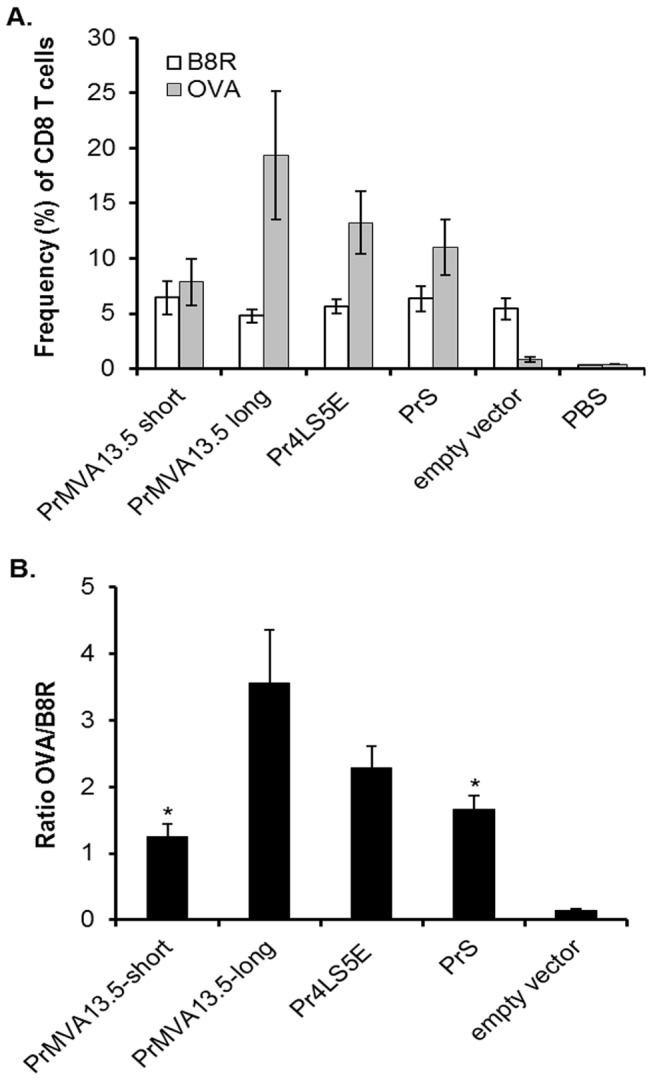
OVA and B8R specific CD8 T cells at the early memory phase.(A) The frequency of OVA- and B8R-specific CD8 T cells were detected for the indicated groups from spleens 10 weeks after the last vaccination using dextramer staining and including memory phenotype markers (CD127 and CD62L). The average for each group is shown +/- SEM values. (B) The average OVA-to-B8R ratios (OVA/B8R) 10 weeks after the third immunization are shown for each group +/- SEM values. Each promoter construct group consisted of 4-5 mice. The empty vector and PBS control groups consisted of 3 mice each. *, indicates the promoter was significantly different when compared to the PrMVA13.5-long promoter (p < 0.05).